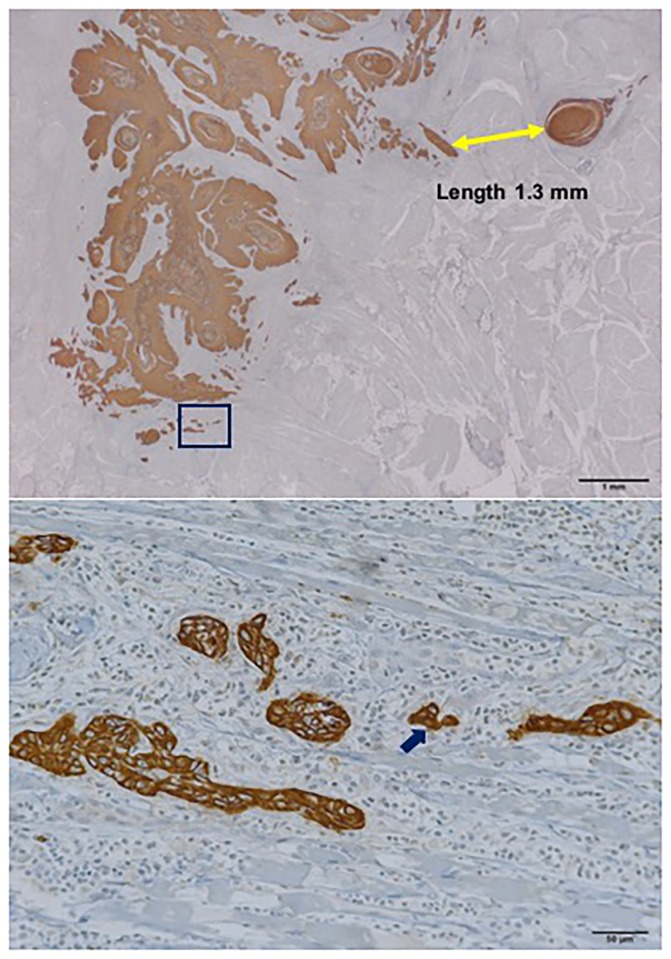
Photographs of immunohistochemical pancytokeratin staining show representative examples of grade 3 mode of invasion and WPOI-5 at x12.5 magnification.The yellow line measures a distance >1 mm between the main tumor and the next focus of dispersed islands. The region in the rectangle is shown at x200 magnification in the lower panel, which shows 1 bud.